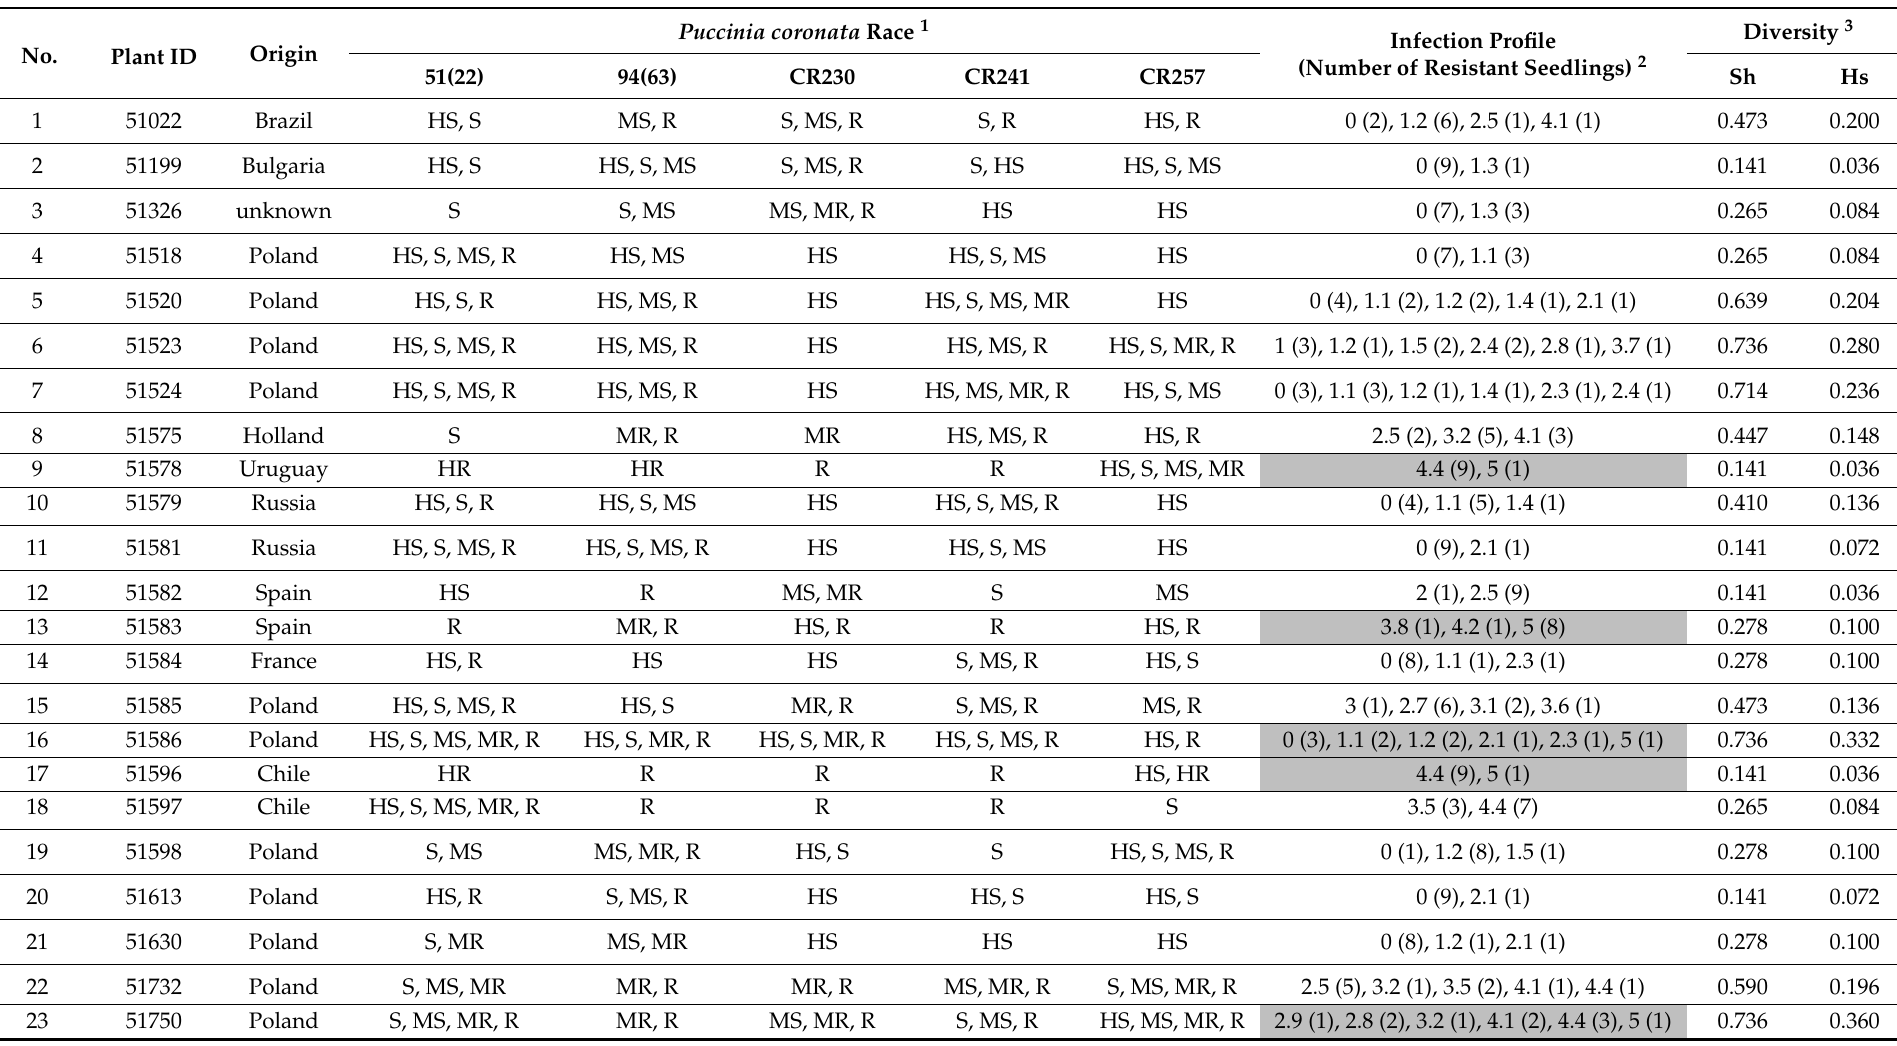
Table 1. Crown rust resistance phenotypes of Avena strigosa L. genotypes. Accessions, within which fully resistant plants were present, are highlighted in